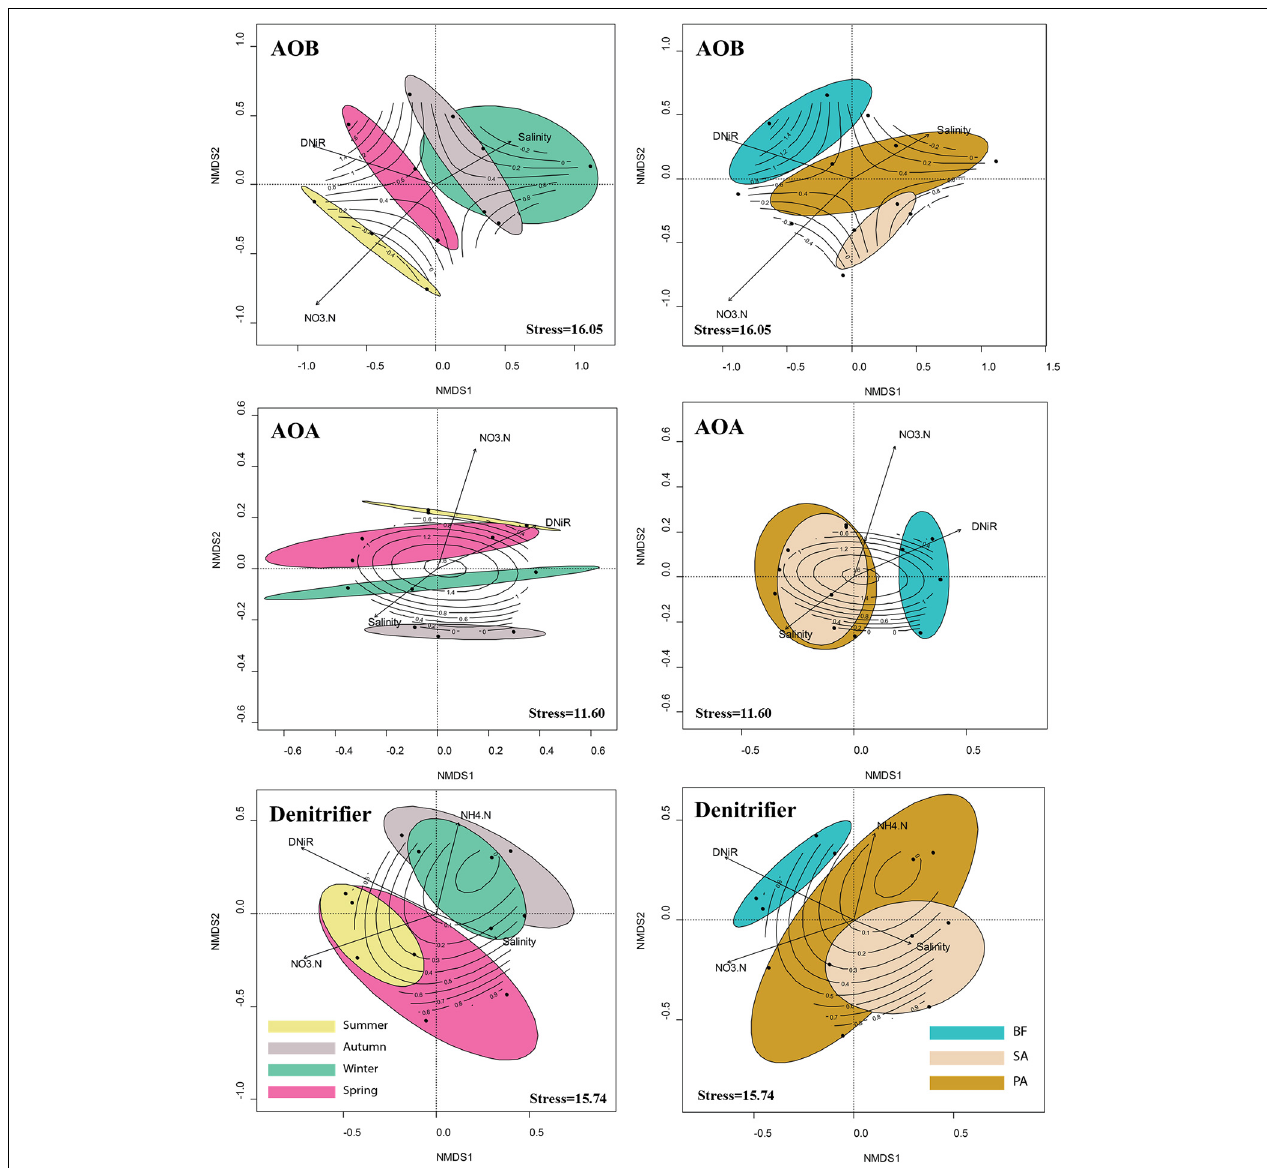
FIGURE 5 | Non-metric multidimensional scaling (NMDS) ordination of sampling sites based on the composition of the AOB, AOA, and denitrifier communities as determined by the T-RFLP analysis. The seasonal and vegetative patterns of the communities are visualized by enclosing the samples from the same season or same soil type in a colored ellipse (at 95% confidence). Significant environmental variables